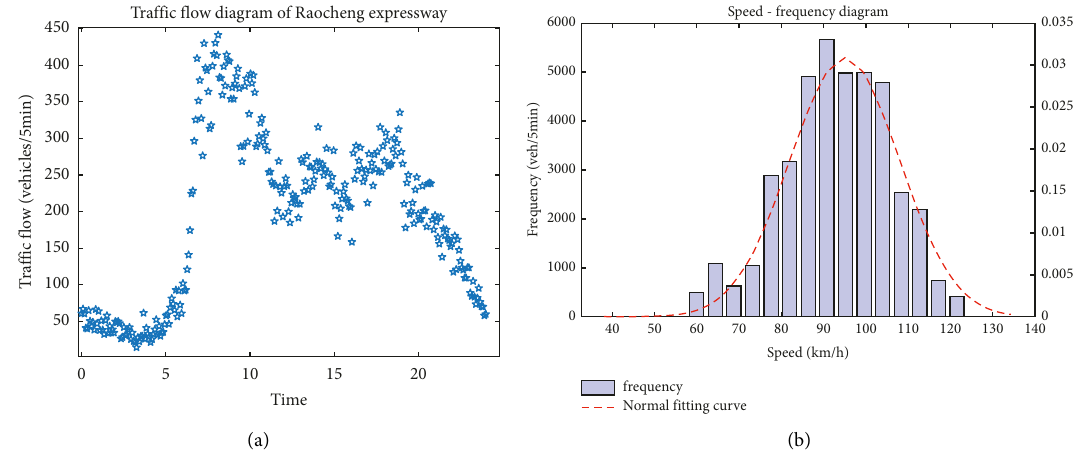
Figure 3: Traffic flow features: (a) traffic flow and (b) speed